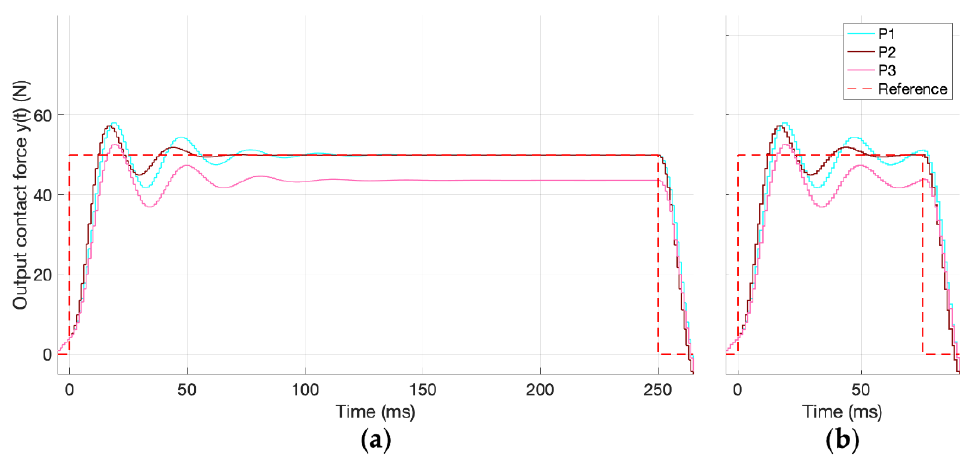
Figure 4. Force tracking of the MPC algorithm for the MIL: ( a ) refers to the R1 reference signal (50 N, 250 ms), ( b ) refers to the R2 reference signal (50 N, 75 ms). Reference force signal in red dashed lines, continuous lines refer to the output contact force obtained for different control parameters (see Table 4). Table 4. MIL MPC tuned parameters and the resulting performance indices. The labels and colors refer to the corresponding curves presented in Figure 4.